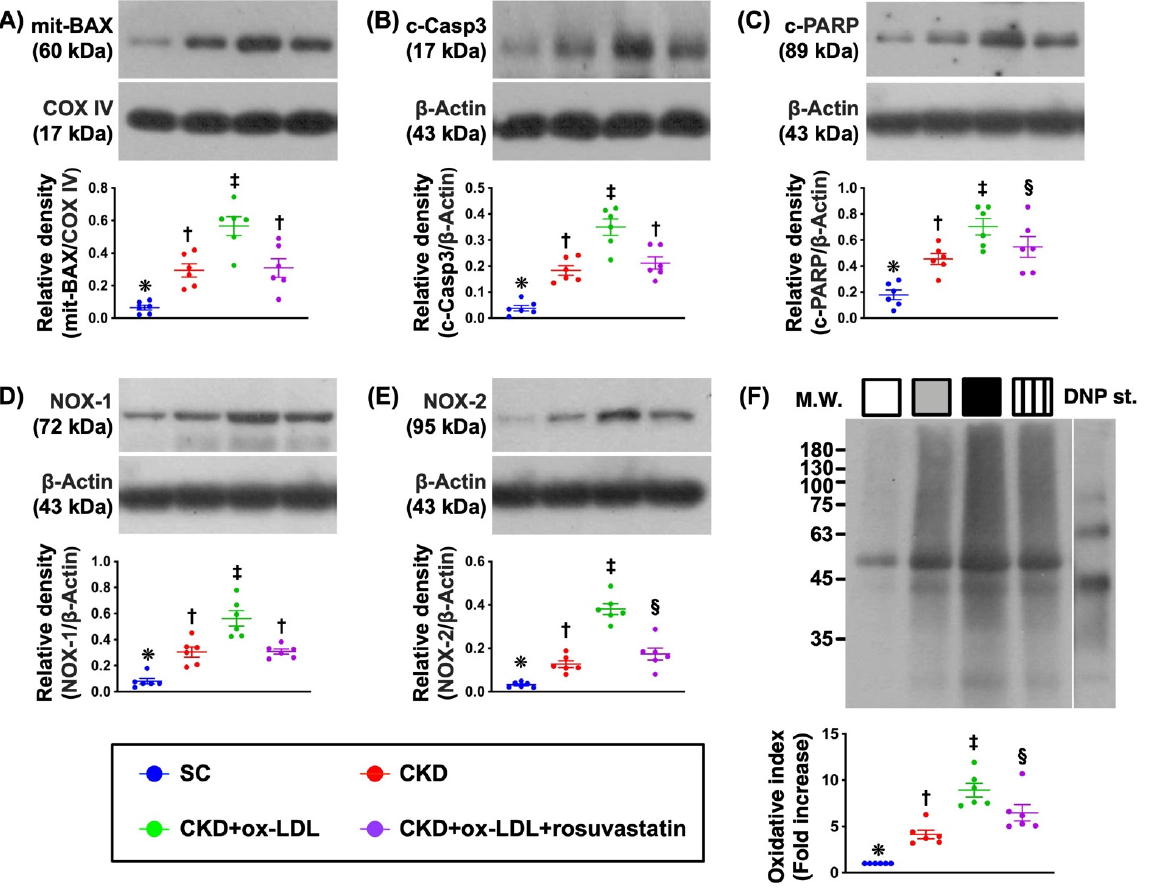
Figure 7. Protein expressions of apoptotic and oxidative stress biomarkers in kidney parenchyma by day 42 after CKD